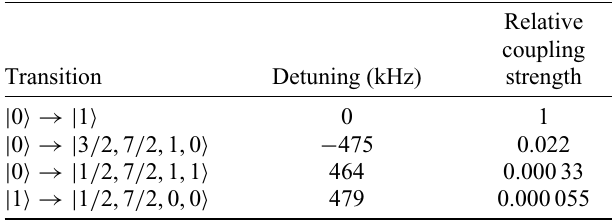
TABLE II. Possible states that may be accessed from the | 0 (cid:2) = (cid:2) = | 3 / 2, 5 / 2, 0, 0 (cid:2) and | 1 (cid:2) = | 3 / 2, 5 / 2, 1, 1 (cid:2) | m I Na , m I Cs , N , m N computational basis states with a σ + polarization from N = 0 to N = 1 at 859.3 G. The energies of these transitions are also given, where a positive detuning is a transition that has larger energy separation. The relative strength of these transitions are also listed.